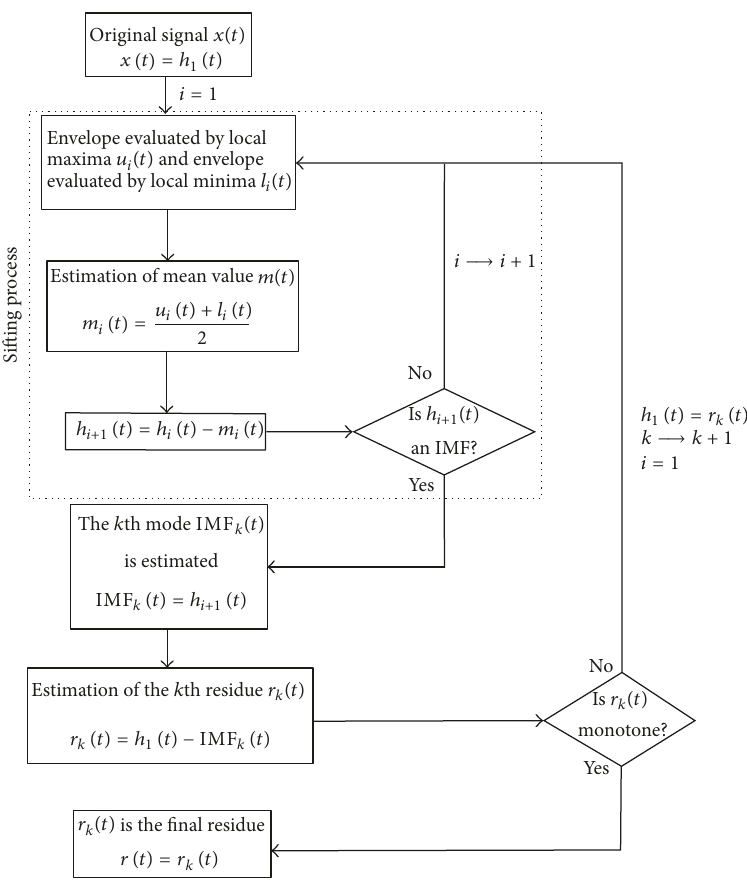
Figure 1: Flow-chart of the EMD